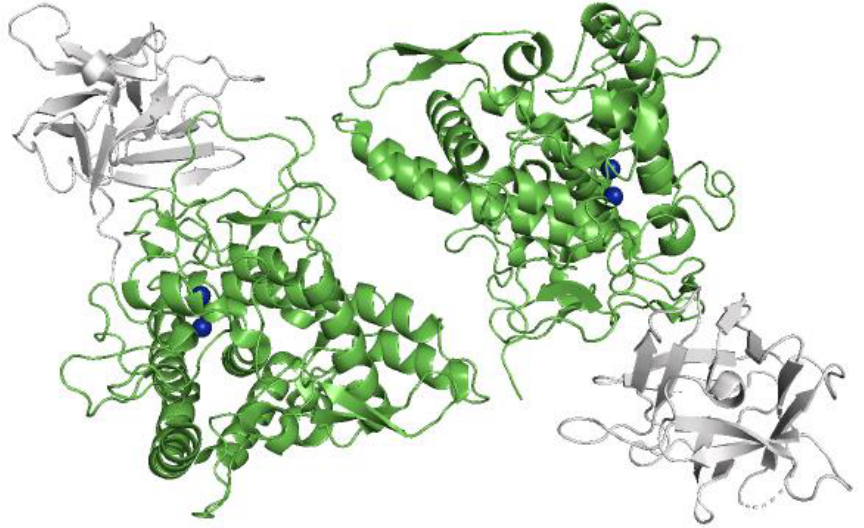
Figure 2. Three-dimensional structure of Agaricus bisporus tyrosinase TyrAB . H subunits (green), L subunits (grey). Copper atoms (blue). Structure was obtained from PDB data bank with the following codes: 2Y9W. Figure was drawn using Pymol program.